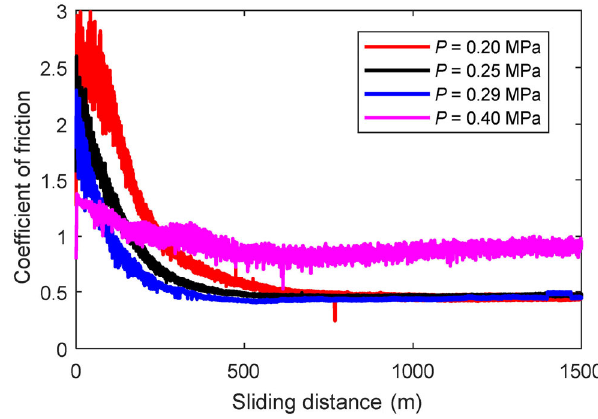
Fig. 8 Coefficients of friction as a function of sliding distance for the composite 15 EF at different contact pressures.